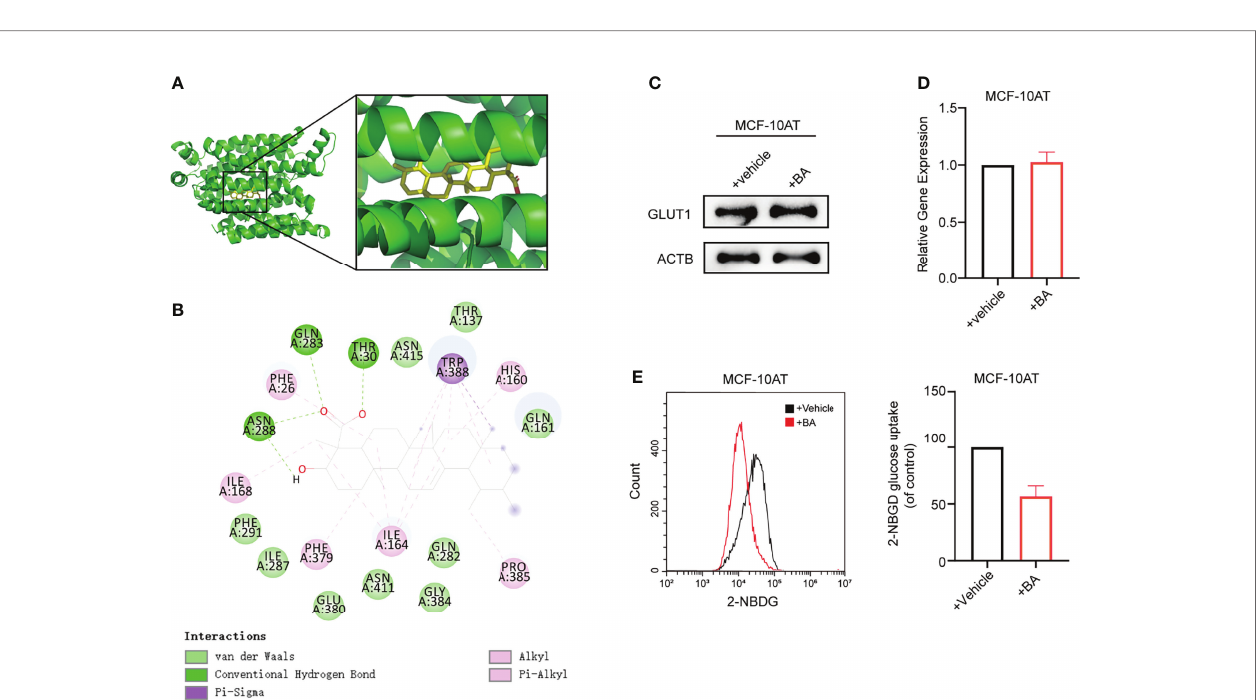
FIGURE 4 | b -BA interacts with GLUT1 to block glucose uptake in MCF-10AT. (A) Visualization of 3D interaction of docked complex composed of GLUT1 and b - BA. (B) Ligand interactions between b -BA and GLUT1. (C) The protein expression of GLUT1 in MCF-10AT cell with or without b -BA treatment was measured by Western blot. (D) The gene expression of GLUT1 in MCF-10AT cell with or without b -BA treatment was measured by real-time PCR. (E) The 2-NBDG glucose uptake in GLUT1 overexpression MCF-10AT and its corresponding control cells was measured by FACS. Statistics are shown in the right panel as mean fl uorescent intensity ±